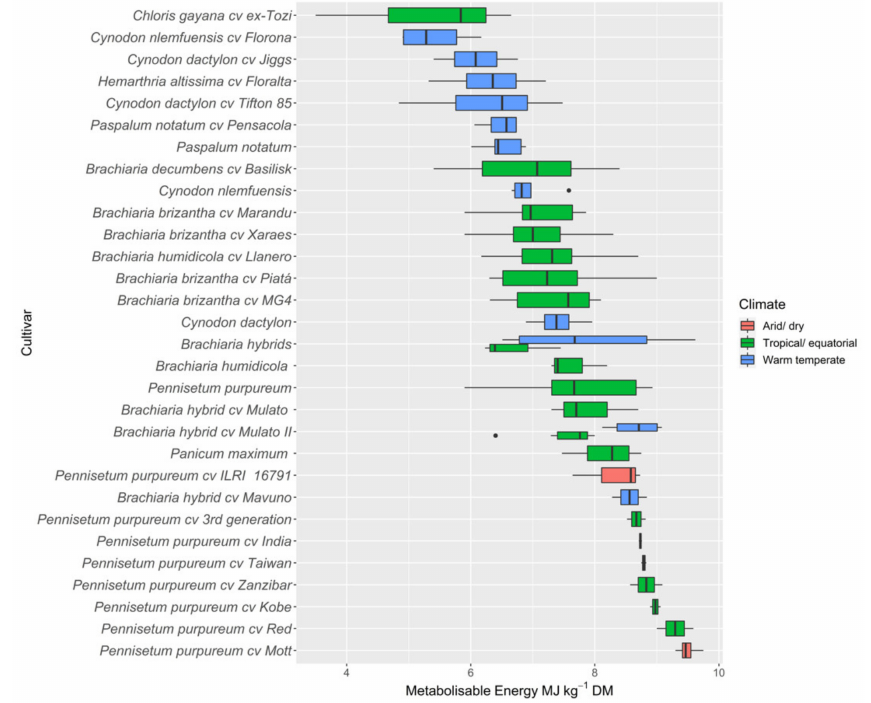
Figure 3. Ascending median values of metabolisable energy (MJ kg − 1 DM) in tropical pasture species and cultivars grown in contrasting environments.